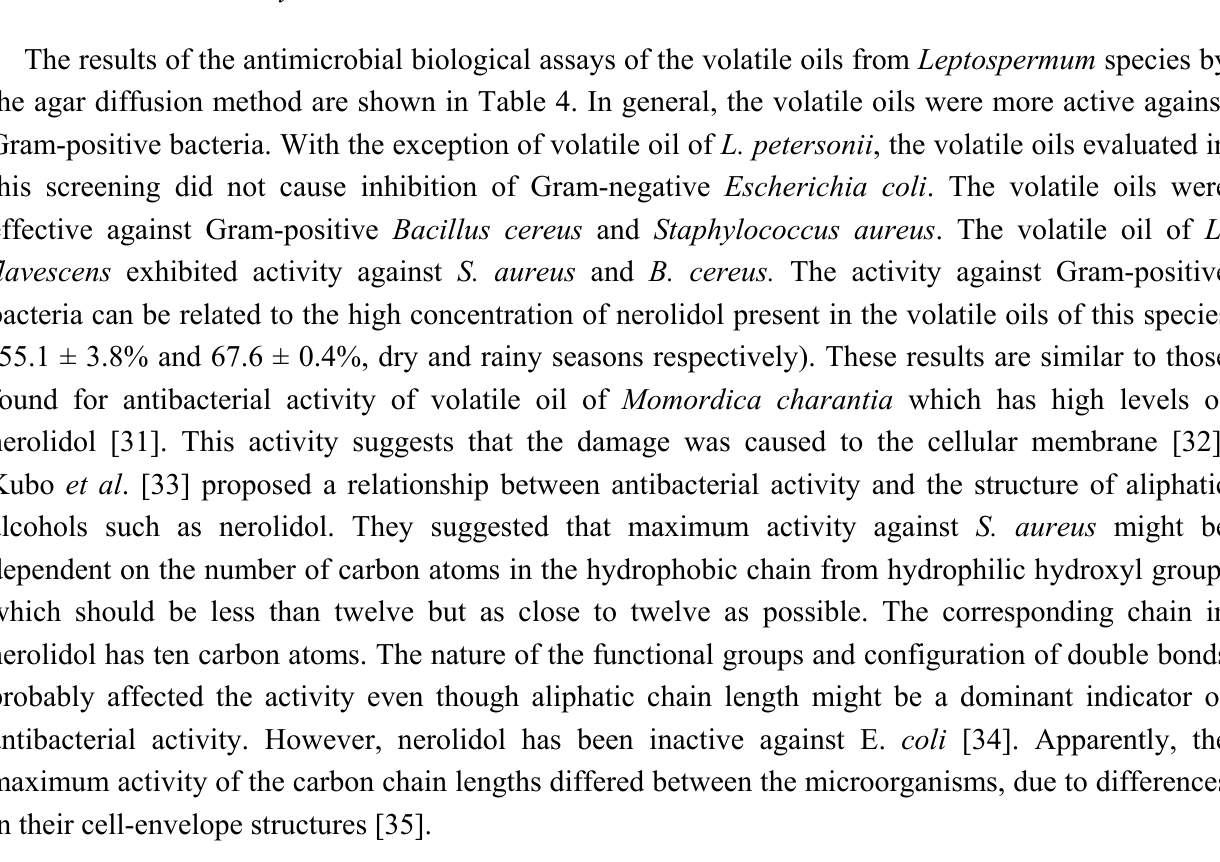
Table 3. Content (%) of different classes of terpenes in the volatile oils of species of Leptospermum. LM LF LP LP flower Dry Rainy Dry Rainy Dry Rainy HD SPME Monoterpene hydrocarbon 37.8 1.2 14.2 1.5 0.6 0.3 0.6 15.1 Oxygenated monoterpenes 11.7 3.8 14.0 8.0 94.3 91.9 94.0 65.0 Sesquiterpene hydrocarbon 31.9 73.0 9.0 7.8 0.1 0.4 0.1 7.3 Sesquiterpene Oxygenated 6.8 5.1 55.2 67.8 - - - - Hydrocarbon/